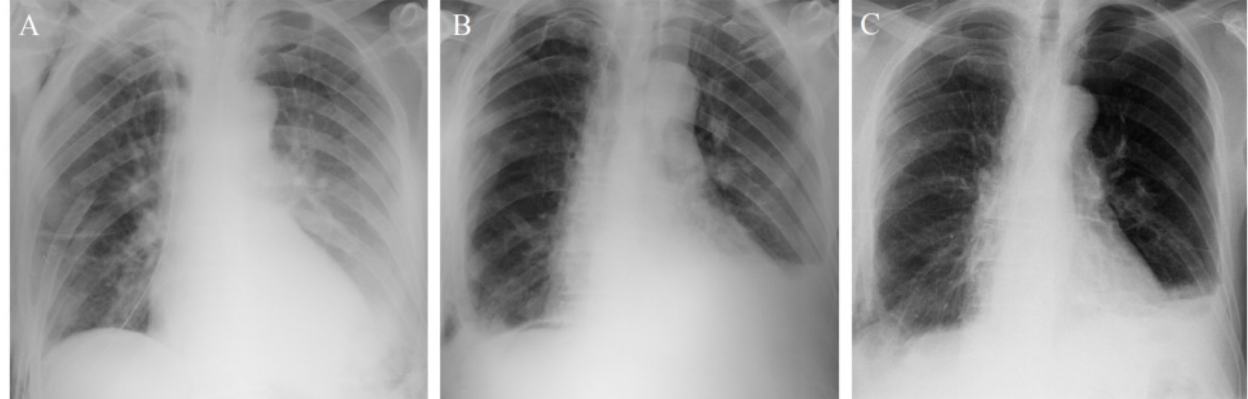
Figure 1. Chest x-rays from post-operative day 2 ( A ), post-operative day 7 ( B ), post-operative day 18 ( C ).